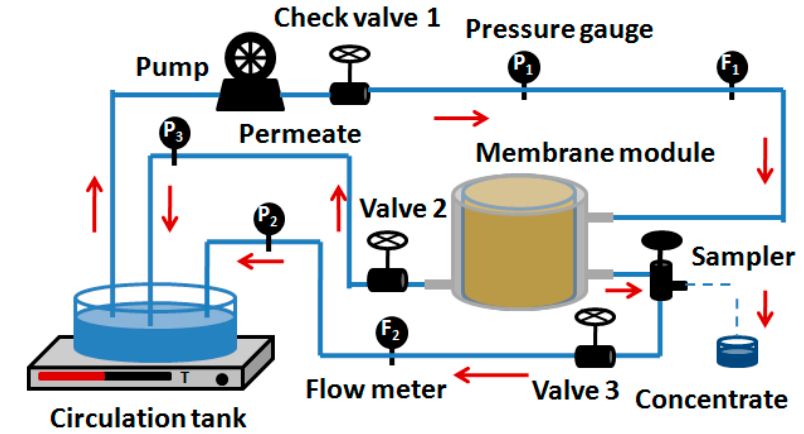
Figure 2. Schematic illustration of the reverse osmosis system.